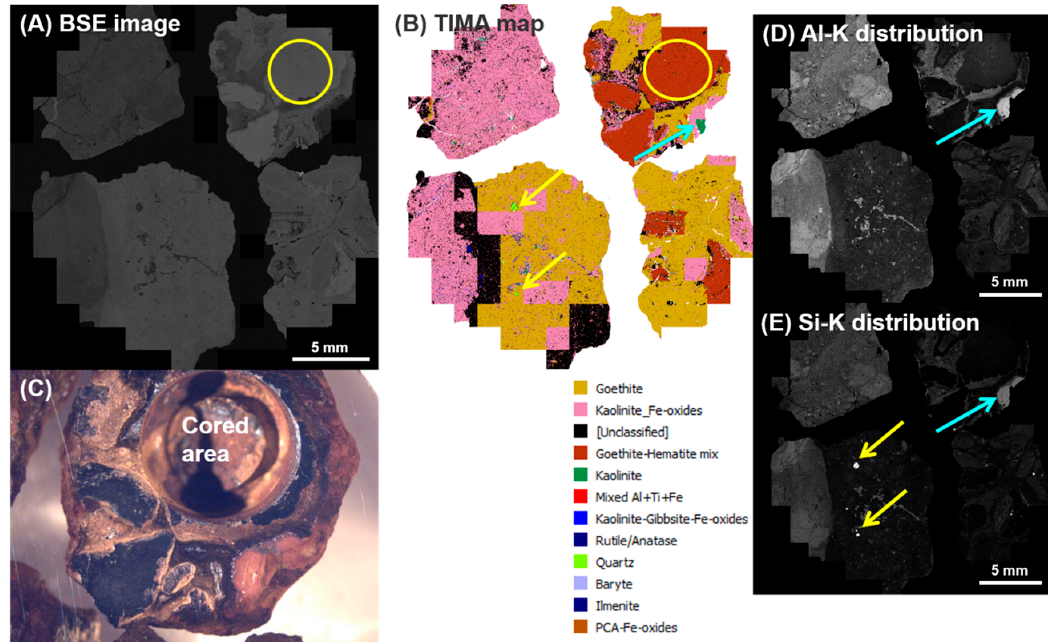
Figure 18. Composite back-scattered electron (BSE) ( A ) and TIMA ( B ) mineral distribution map of the NSP (#25473) used to locate areas suitable for (U–Th)/He-dating. The area circled in yellow ( A ) shows the coring location (as shown in C ). Element maps of the Al–K ( D ) and Si–K ( E ) distribution also aid in identifying areas suitable for (U–Th)/He-dating. Bright, white-contrast spots in the Si–K map (high Si content— E , yellow arrows) indicate the presence of quartz, whereas areas with co-incidentally enriched Al and Si ( D ), indicate the presence of clay (e.g., kaolinite—blue arrows).